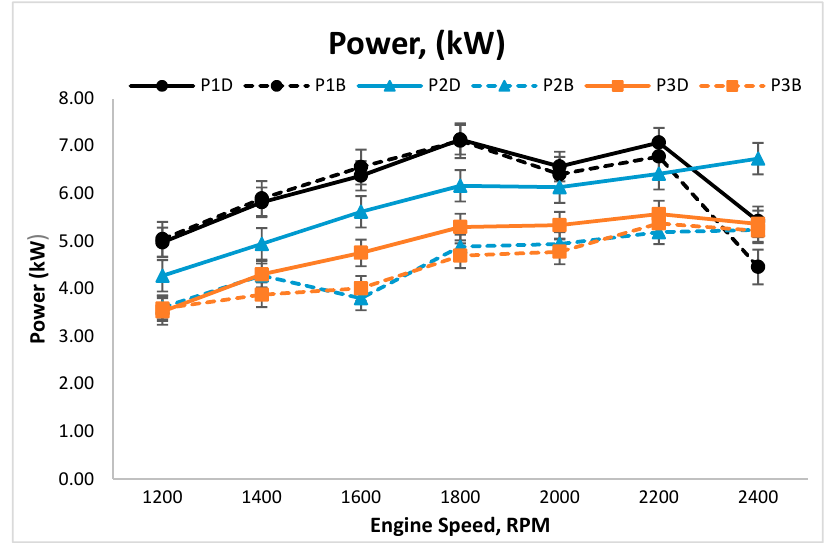
Figure 13. Power (kW) produced at various engine speeds.